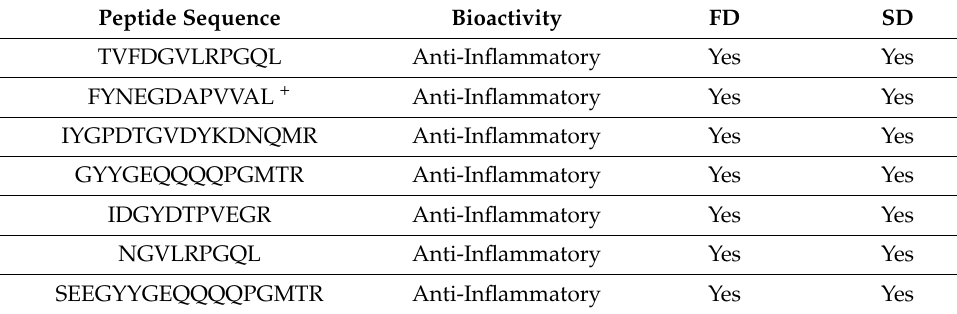
Table 1. Key peptides within FD and SD samples.